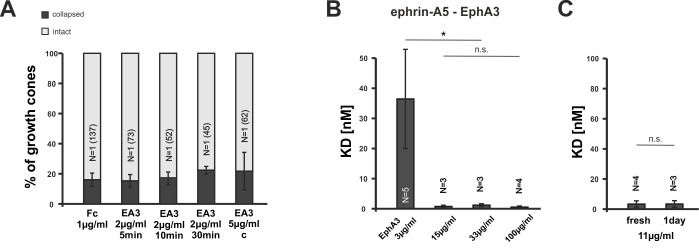
EphA3 collapse assays and ephrin-A5/EphA3 dissociation constants.(A) Moderate concentrations of EphA3-Fc (EA3) do not trigger a collapse of nasal or temporal GCs, neither in dimeric nor in an antibody clustered form (Fc, 1 µg/ml, 20 min: 16.1% collapsed; EA3, 2 µg/ml, 5 min: 15.3%; 10 min: 17.3%; 30 min: 22.4%; EA3, 5 µg/ml antibody-clustered (C), 20 min: 21.7% collapsed). Antibody-induced clustering was achieved by preincubation of EphA3 with anti human Alexa Fluor488 goat IgG (Thermo Fisher Scientific, Waltham, MA, USA) in a molar ratio of 2:1 (EphA3:AB) for 1 hr at room temperature. N: number of independent experiments; number of analyzed GCs in brackets. Error bars represent standard deviations. (B) Concentration-dependent binding of ephrin-A5 to EphA3 (see Materials and methods for details). Dissociation constants (KD) of ephrin-A5 and EphA3 decrease abruptly with increasing EphA3 concentrations, indicating a sharp increase in binding affinity, which is potentially due to the concentration-dependent formation of EphA3 clusters in solution. KDs ephrin-A5 binding to: EphA3 3 µg/ml: 36.68 nM; EphA3 15 µg/ml: 0.76 nM; EphA3 33 µg/ml: 1.23 nM; EphA3 100 µg/ml: 0.55 nM. (C) Potential EphA3 clusters are stable for at least one day in solution at a concentration of 11 µg/ml as indicated by a constant KD (fresh EphA3, 11 µg/ml: 3.37 nM; 1 day old EphA3, 11 µg/ml: 3.40 nM). (B, C) N: number of independent experiments. Error bars represent standard deviations. T-test with n.s.: α ≥0.05; *: α <0.05.DOI:
http://dx.doi.org/10.7554/eLife.25533.00610.7554/eLife.25533.007Figure 2—figure supplement 1—source data 1.Original data underlying bar charts of Figure 2—figure supplement 1.